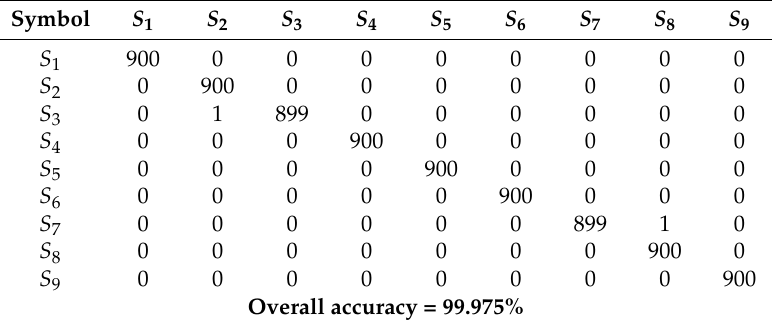
Table 11. Faulty section identification results for noise-free measurement.